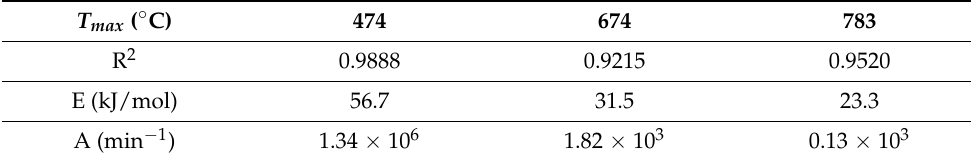
Table 4. Effect of maximum pyrolysis temperature on the kinetic parameters E, A.